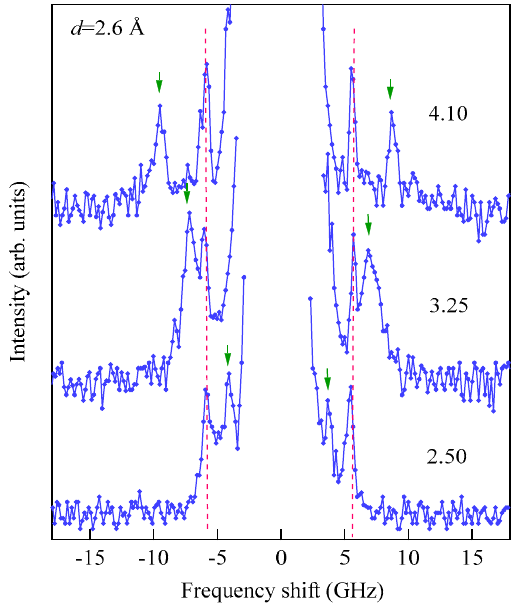
Figure 16. Magnetic field development of BLS spectra observed at d = 2.6 Å. The applied field is indicated on each spectrum. SW peaks are indicated by arrows. The peaks on the broken lines are due to the Rayleigh surface acoustic waves, which mainly reflect the elastic properties of the Au/Ag/MgO structure